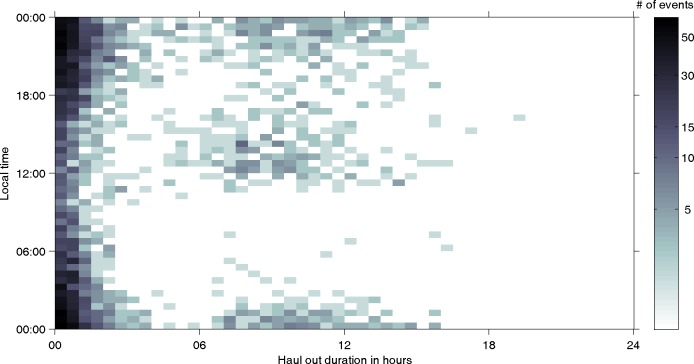
Logarithmic density plot of haul-out timing over duration.Number of haul-out events over the centre time of haul-outs (Tm) and duration of haul-outs (Td) for the complete dataset. The darker the grid cell the more events occurred (see colour bar).